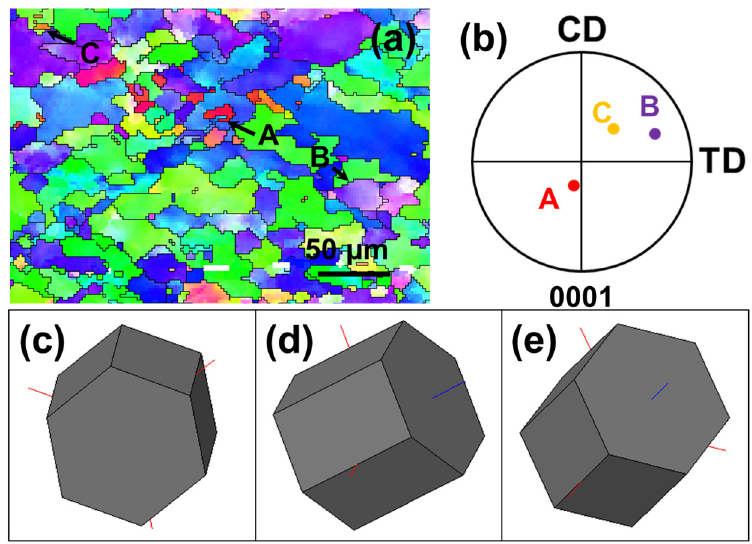
Figure 12. ( a ) EBSD IPF map of the alloy deformed at 350 °C/0.01 s − 1 , ( b ) the orientations relationship on {0001} pole figures of nuclei A, nuclei B and nuclei C and schematic diagram showing the lattice of nuclei ( c ) nuclei A, ( d ) nuclei B, and ( e ) nuclei C.